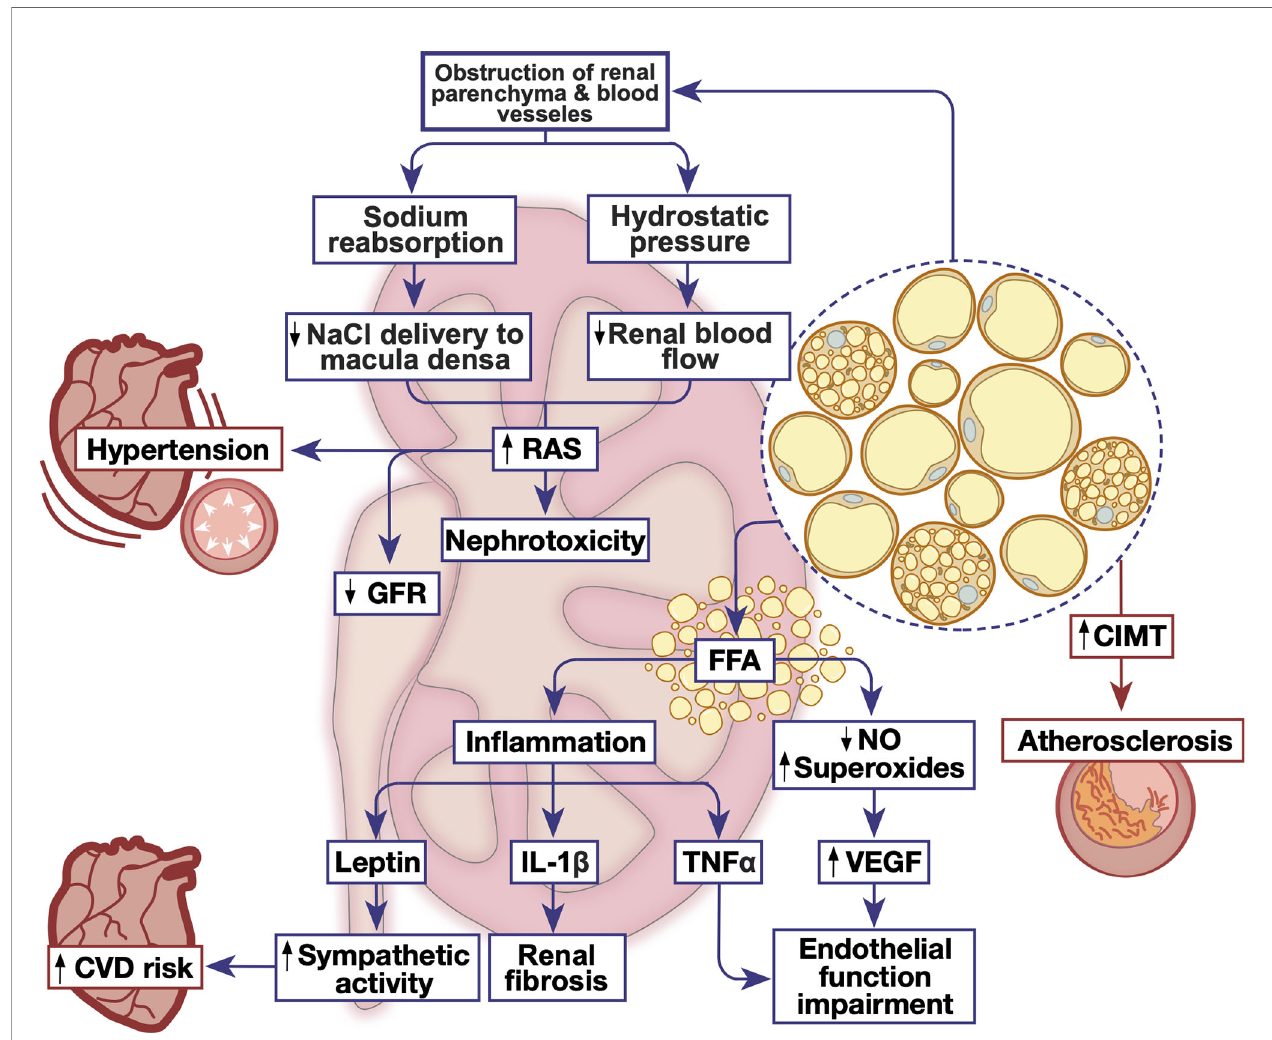
FIGURE 2 | The emerging role of PRAT in renal and cardiovascular homeostatic function. Metabolic dysfunction triggers PRAT deposition and in fl ammation leading to alterations in cardiovascular and renal function, triggering nephrotoxicity and cardiovascular diseases. CIMT, carotid intima-media thickness; CVD, cardiovascular disease; FFA, free fatty acid; GFR, glomerular fi ltration rate; IL-1 b , interleukin-1 beta; NO, nitric oxide; RAS, renin angiotensin system; TNF a , tumor necrosis factor alpha; VEGF, vascular endothelial growth